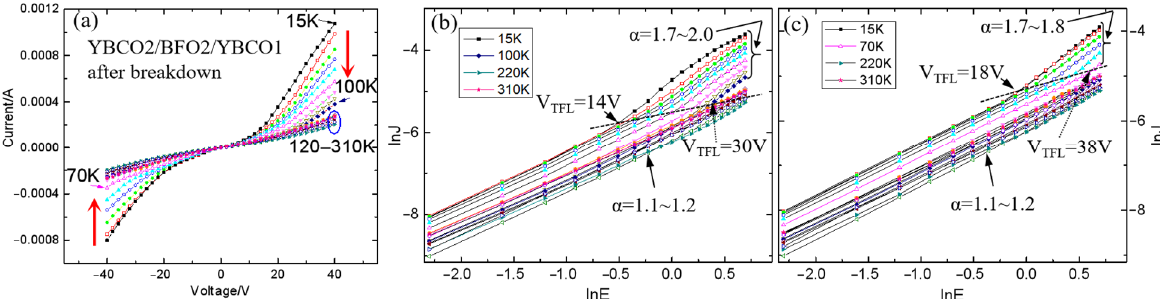
Figure 7. ( a ) Current versus voltage curves of a YBCO2/BFO2/YBCO1 capacitor after breakdown at a temperature ranging from 15 K to 310 K. The corresponding ln J versus ln E curves of the positive bias voltage ( b ) and the negative bias voltage ( c ).